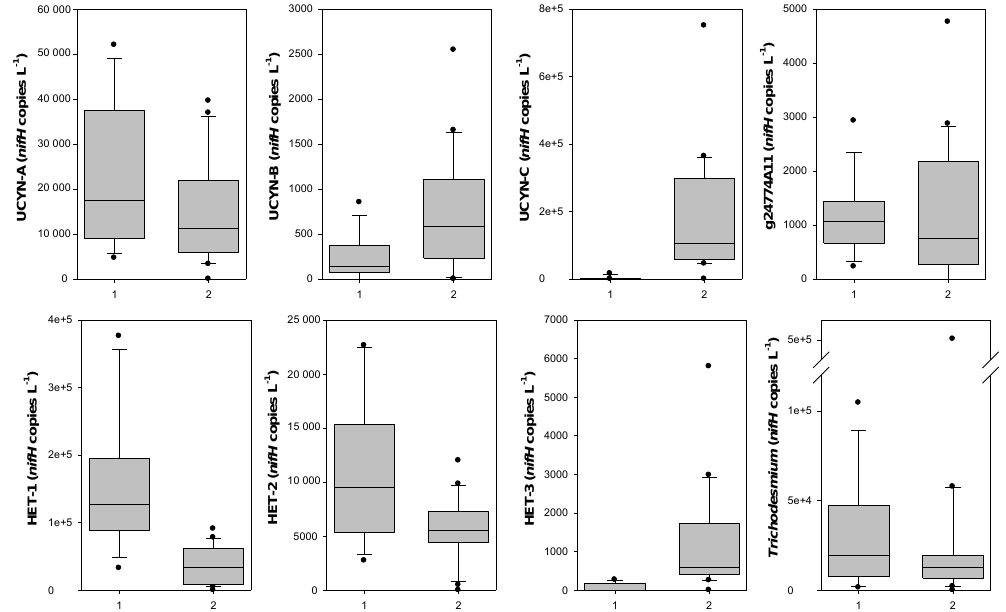
Figure 11. Box plots of targeted diazotrophs groups in nifH genecopiesL − 1 in the three mesocosms during the two periods P1 and P2.